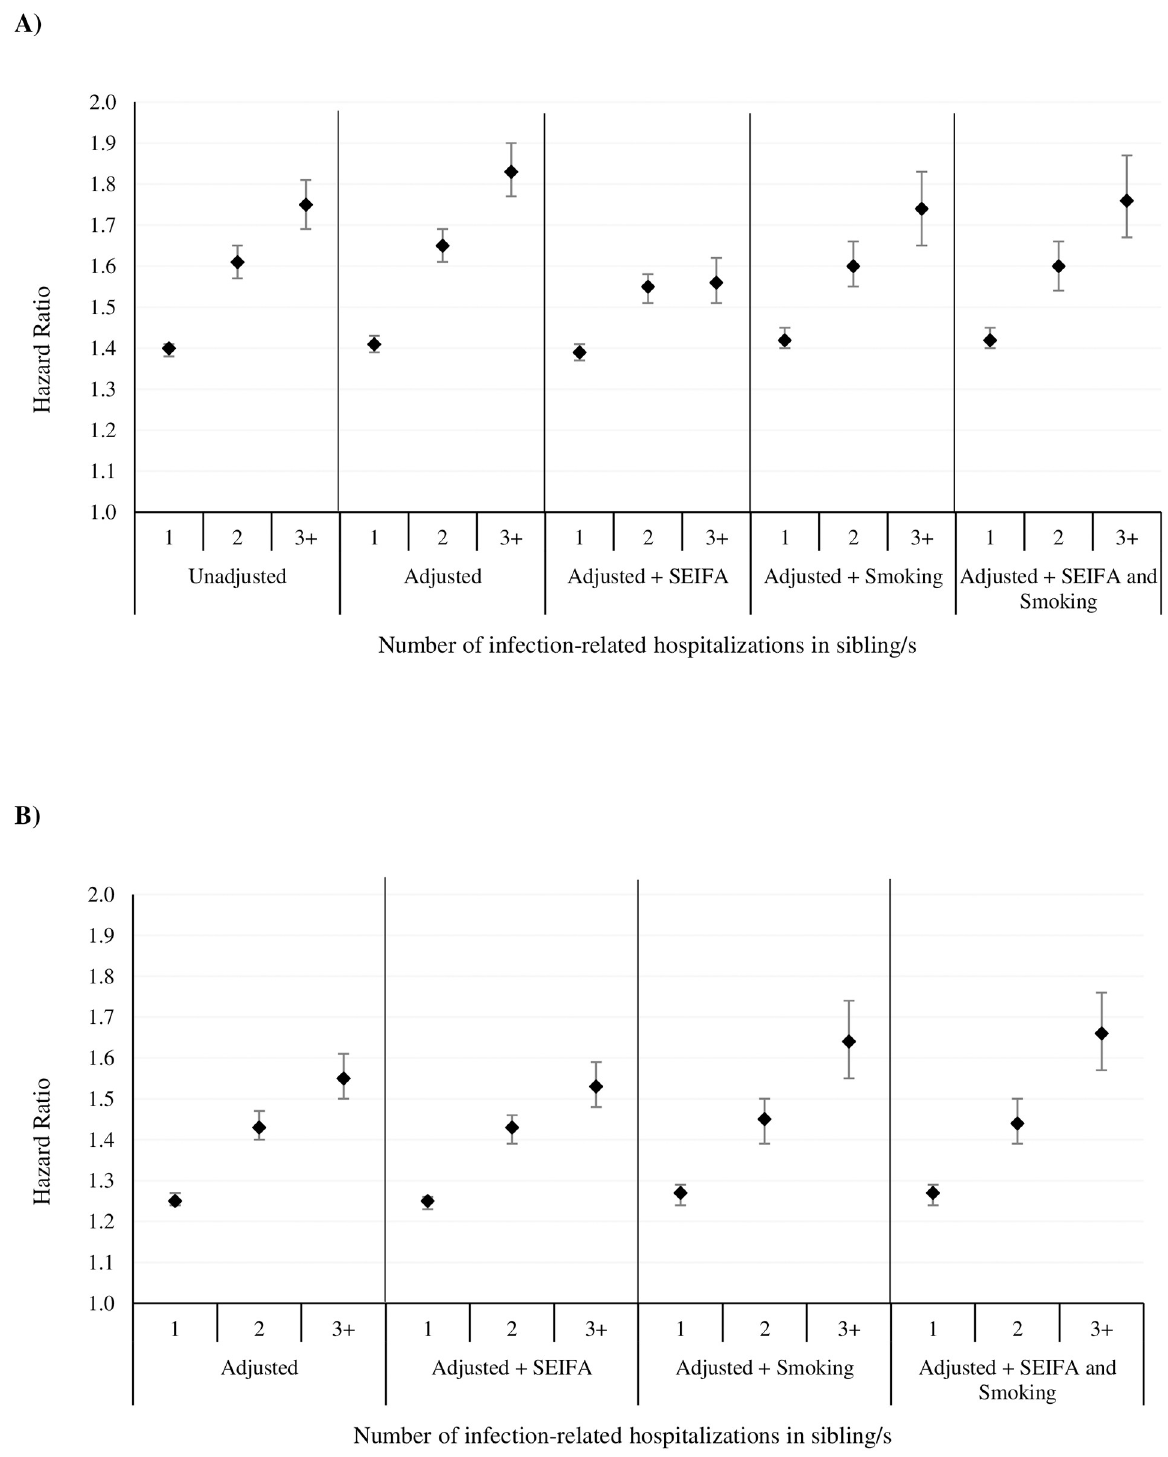
Fig 2. Overall infection-related hospitalization sibling hazard ratios. Adjusted for maternal age, parity, gestational age, birth weight, sex, season of birth, 5-minute Apgar score, birth mode, and birth year. Additional adjustments for SES (from Socio-Economic Index for Areas (SEIFA) data) and smoking during pregnancy. Smoking data available from 1997–2013. (A) Infection-related hospitalization sibling hazard ratios among probands whose sibling/s had infection-related hospitalizations compared to probands whose siblings/s did not have infection-related hospitalizations (reference group). (B) Infection-related hospitalization sibling hazard ratios excluding proband infection-related hospitalization admissions occurring within 30 days following a sibling infection-related hospitalization exposure.